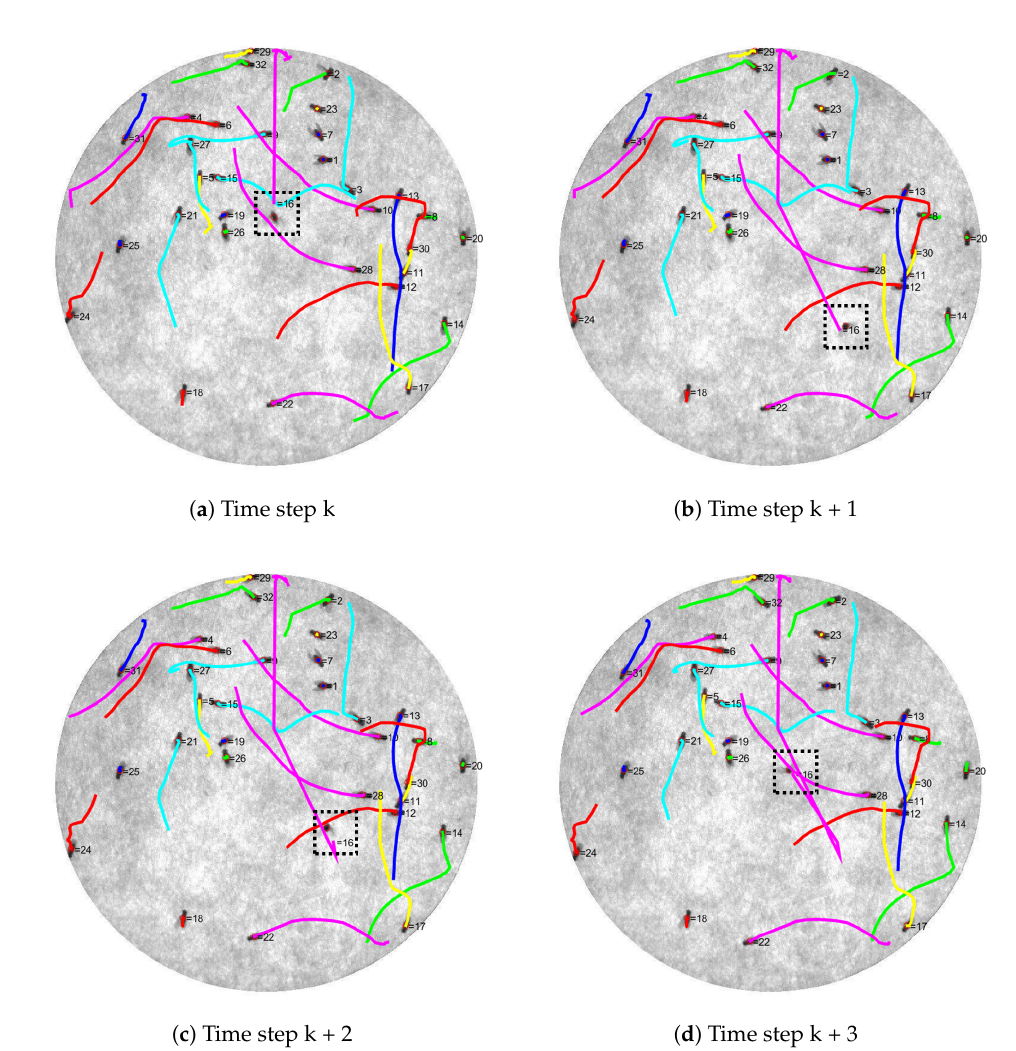
Figure 15. Trajectories images showing the result from the identity assignment. The colored line represents each trajectory from last six time steps. From time step k to k + 3 ( a – d ), there are 18 stationary flies (number 1, 2, 6, 7, 9, 12, 15, 18, 21, 23, 25, 26, 27, 28, 29, 30, and 31). Thirteen flies are detected to have small simple displacement (number 3, 4, 5, 8, 10, 11, 13, 14, 17, 20, 22, 24, and 32). There is a flying fly (fly number 16 enclosed by the black dotted rectangle). At time step k, it flew from the top of the arena to the middle and to the bottom right at time step k + 1. The next time step, it went a bit upward and finally flew back to the middle of the arena at time step k + 3. Each time step is different from its consecutive frame by 0.0526